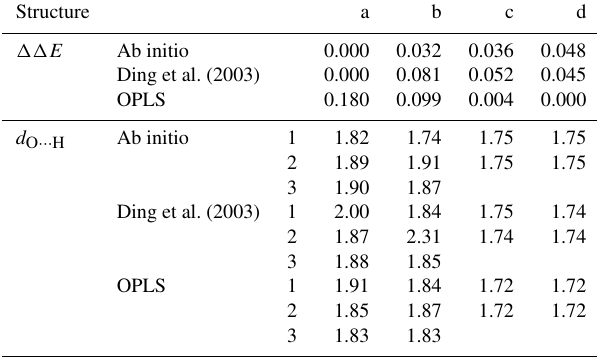
Table 1. Relative energies (cid:49)(cid:49)E (eV) and hydrogen bond distances d O ··· H (Å) for the sulfuric acid dimer structures (a)–(d) in Fig. 1 ob- tained from ab initio calculations by Temelso et al. (2012) and with the force fields by Ding et al. (2003) and Loukonen et al. (2010), following the OPLS